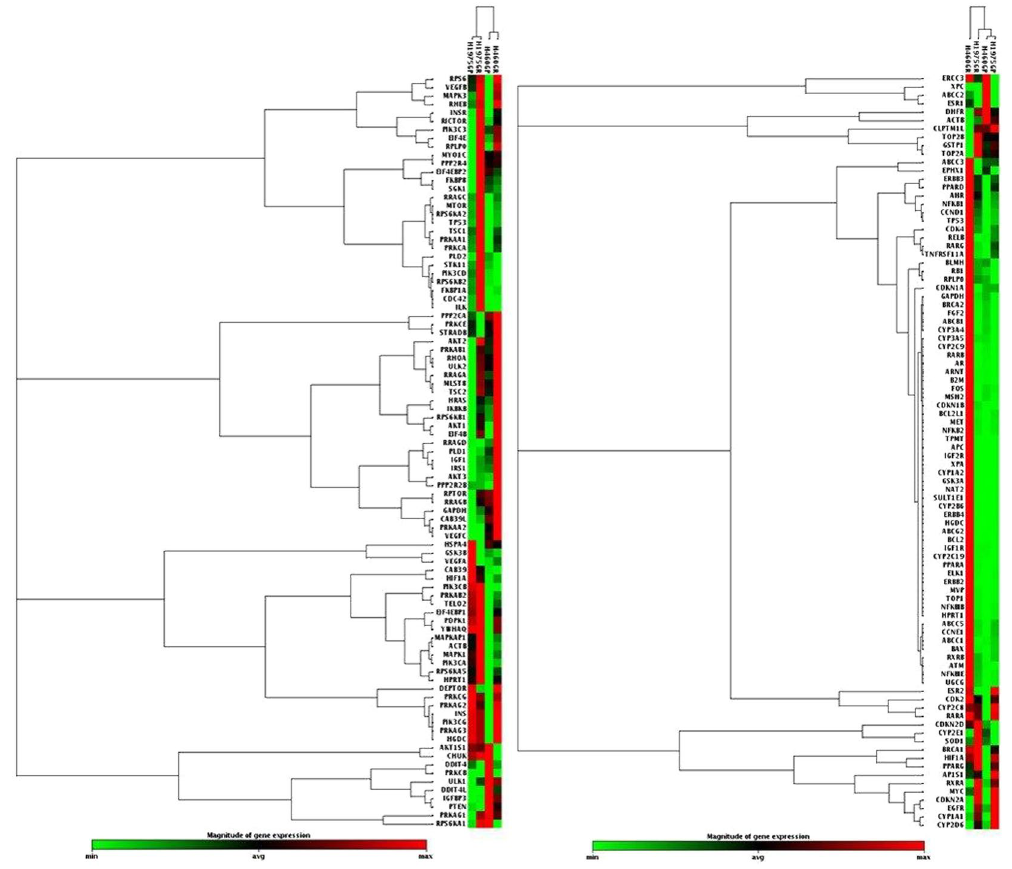
Figure 2. mRNA profile of GDC-0980 resistant NSCLC cell lines. Gene expression was assessed using RT 2 profiler arrays from SABiosciences (left: mTOR panel, right: cancer drug resistance panel) in order to compare gene expression in H1975GP, H1975GR, H406GP and H460GR cell lines. A clustergram was constructed using SABiosciences online